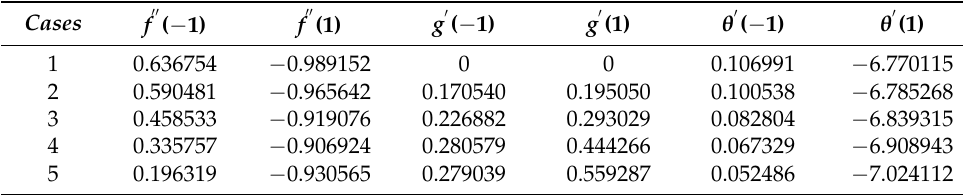
Table 7. Shear stresses, couple stresses, and heat transfer rate for different cases.